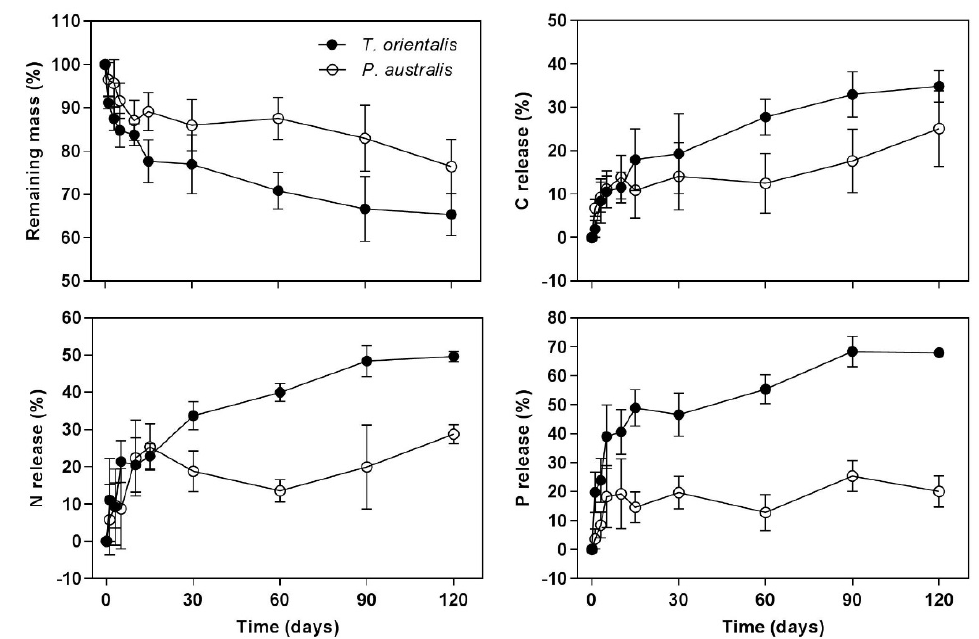
Figure 2. The remaining mass of plant materials and C, N, and P release from plant materials during decomposition.